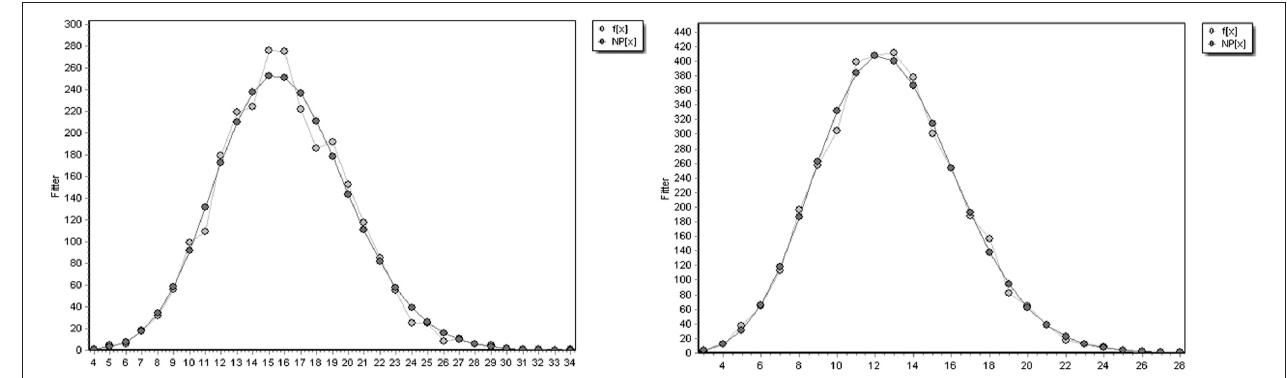
FIGURE 7 | The degree distributions of the random networks of the DHH (left) and the NH (right).